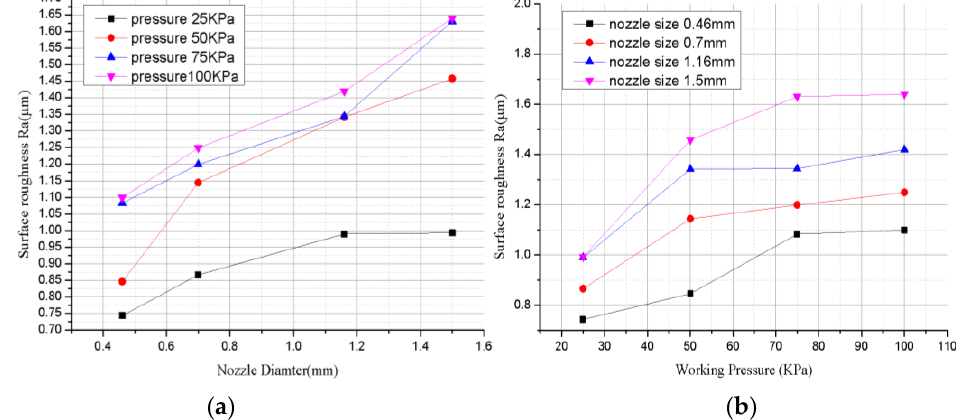
Figure 4. Experimental results of surface roughness for SiC, ( a ) nozzle diameter, ( b ) working pressure.